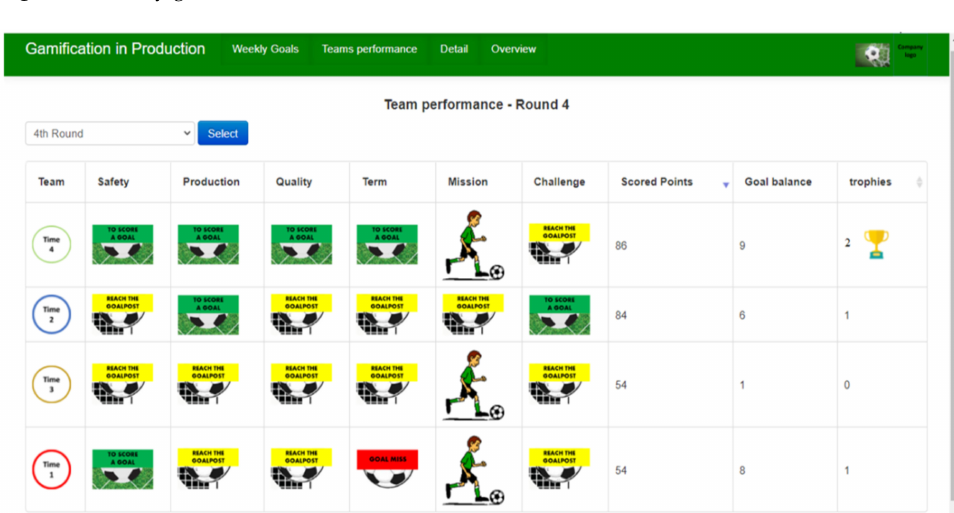
Figure 3. Team performance